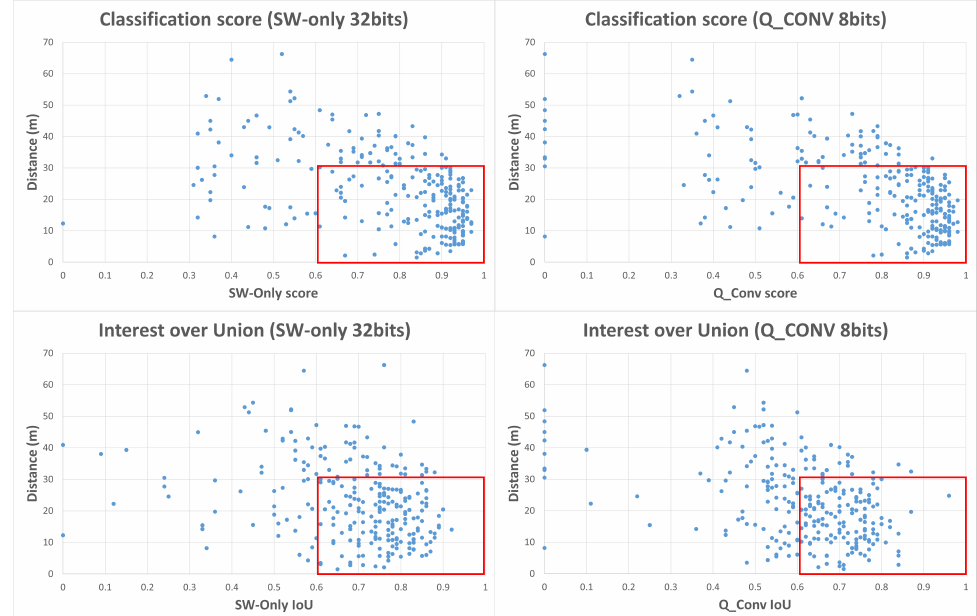
Figure 16. Scoreclassification and IoU distribution regarding object distance to LiDAR sensor. Left presents score and IoU for SW-only model version, right side presents results for quantized backbone convolution